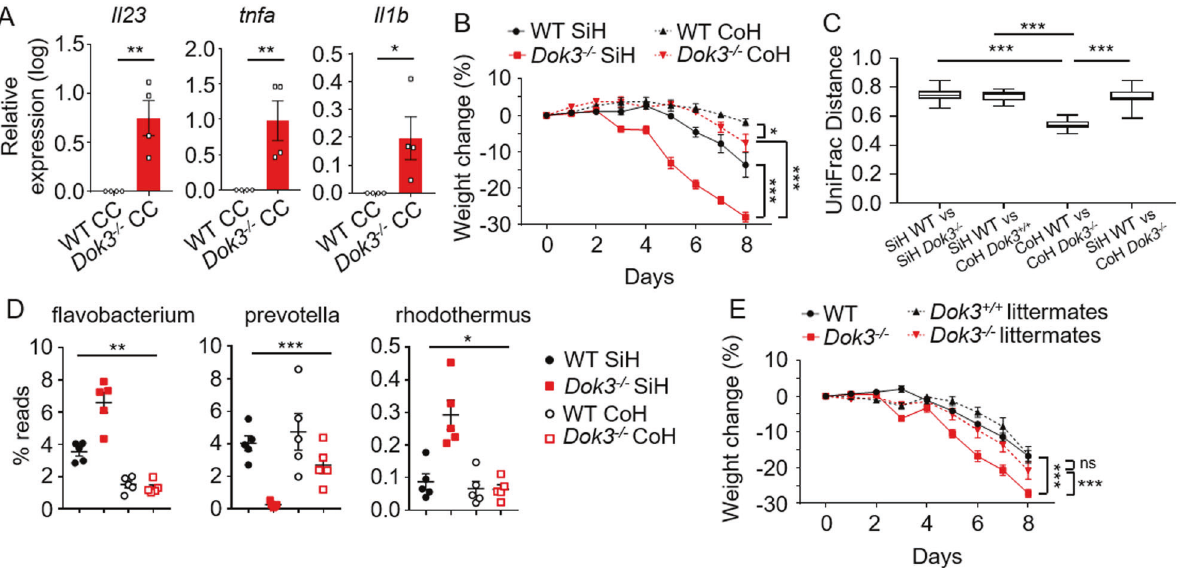
Fig. 3 Microbiome in Dok3 − / − mice regulates colitis susceptibility. A RT-qPCR analysis of Il23 , tnfa , and il1b expression relative to b-actin expression in WT lamina propria cells following 3 h stimulation with cecal contents (CC) from WT or Dok3 − / − mice. Data is shown as mean ± SEM ( n = 4). * p = 0.04, ** p = 0.005, 0.01 (from left to right), unpaired two-tailed Student ’ s t -test. B Singly-housed (SiH) or co-housed (CoH) WT and Dok3 − / − mice were given 2% DSS in their drinking water for 7 days and their body weights measured daily. Data is shown as mean ± SEM ( n = 5). * p = 0.03, *** p < 0.0001, two-way repeated-measures ANOVA. C Unweighted UniFrac distance between SiH and CoH WT and Dok3 − / − mice ( n = 5). *** p < 0.0001, Kruskal – Wallis test with Dunn ’ s post-hoc test. D Relative abundance of major bacterial genera in singly-housed (SiH) or co-housed (CoH) WT and Dok3 − / − mice fecal microbiota. Data is shown as mean ± SEM ( n = 5). * p = 0.02, ** p = 0.006, *** p = 0.0001, two-way ANOVA. E Dok3 + / + and Dok3 − / − littermates or non-littermates were given 2% DSS in their drinking water for 7 days and their body weights measured daily. Data is shown as mean ± SEM ( n = 5). *** p < 0.0001, 0.0008 (from left to right), two-way repeated-measures